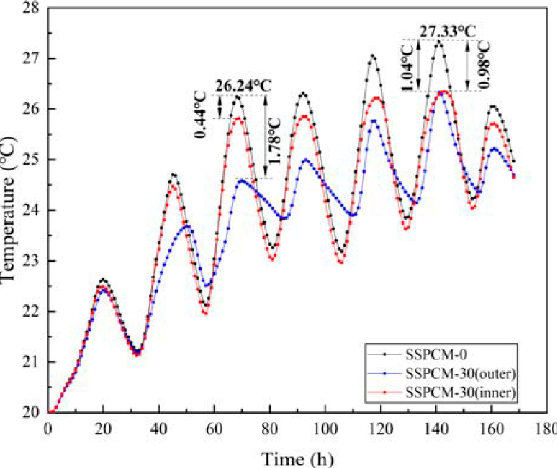
Figure 12. The liquid fraction of the SSPCM layer with different SSPCM thicknesses.